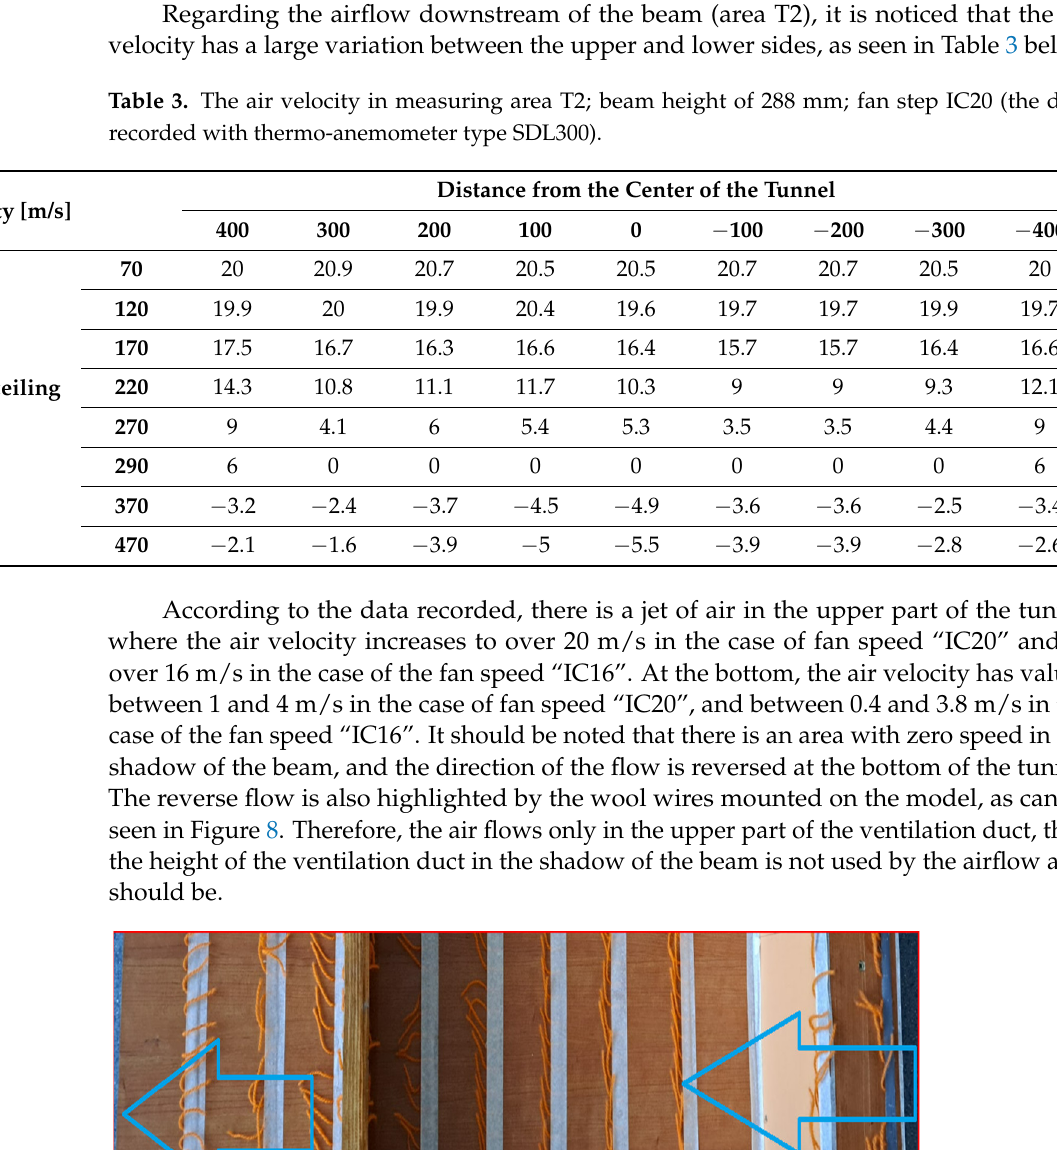
Table 2. The average velocity in measuring area T1; beam height of 288 mm. Fan Speed Step Velocity without Model [m/s] Velocity with Model [m/s] IC20 16.6 8.1